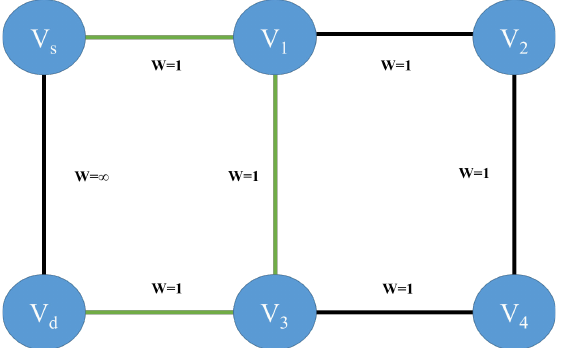
Figure 11. Example of three potential paths in reliable intervehicular routing